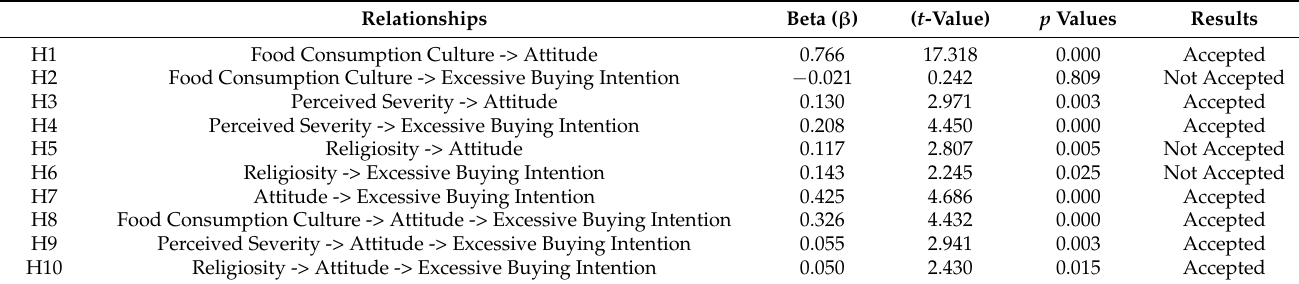
Table 5. The results of